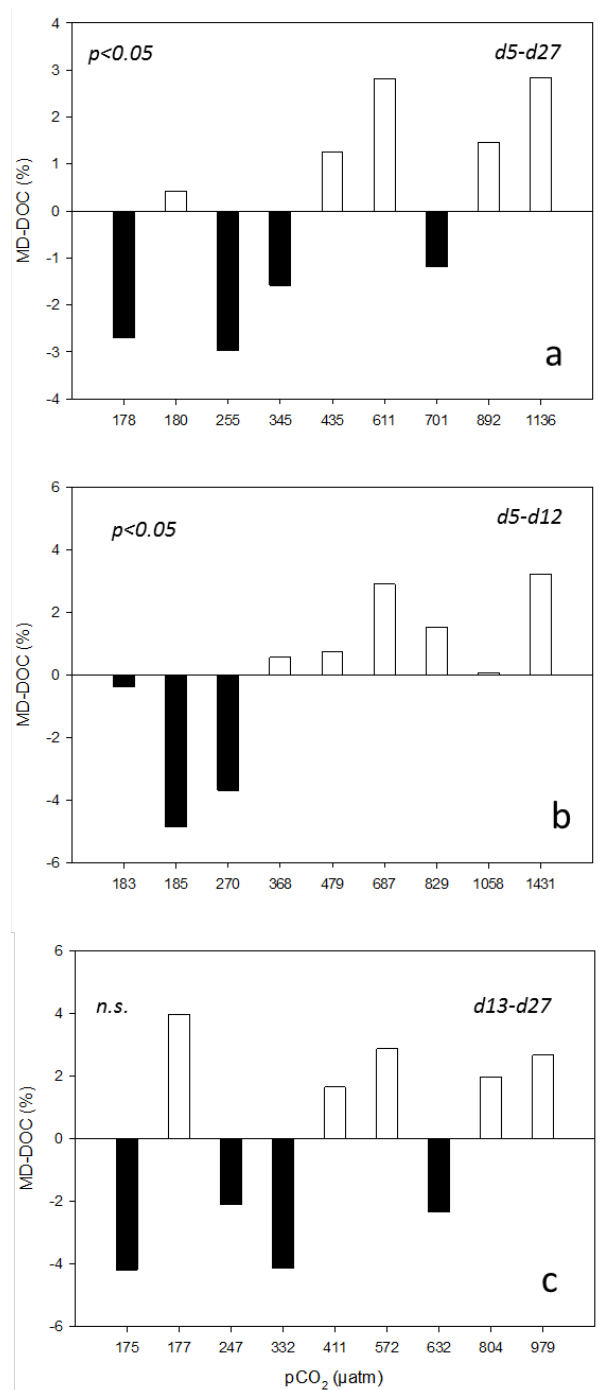
Fig. 11. Mean deviations of DOC concentrations (MD DOC , %) for the nine mesocosms, for (a) the total period of observation (day 4–day 27; n = 24), (b) the period before nutrient addition (day 4–day 12; n = 10), and (c) the period after nutrient addition (day 13–day 27; n = 14). Significance of relation between MD DOC and average p CO 2 at the time of observation was calculated by lin- ear regression. Fjord samples were not